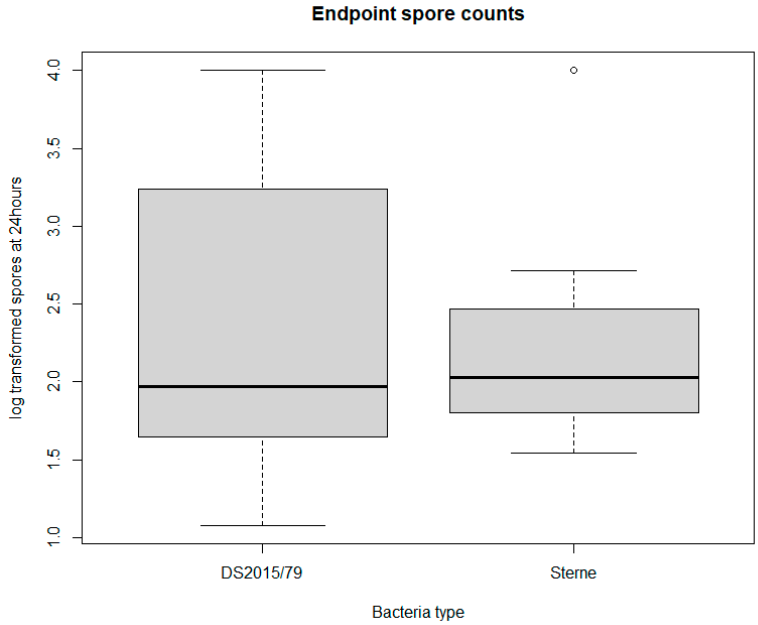
Figure A1. Median and box plots of endpoint spore counts between Bacillus anthracis strains DS201579 and Sterne vaccine strain. Figure A2A–C: Cell and spore, counts di ff er between the two bacteria types. There is far more variation in B. anthracis DS201579 cell counts than Sterne. The median of the two bacteria remain comparable never-the-less.